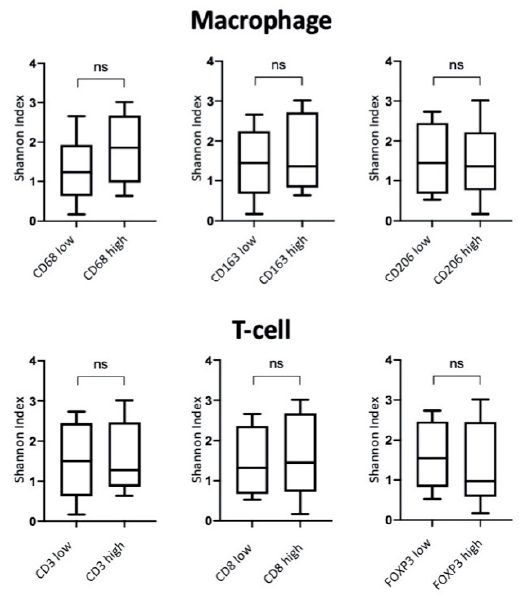
Figure 8. Taxonomic diversity between different groups depending on the phenotype of the inflammatory infiltrate.